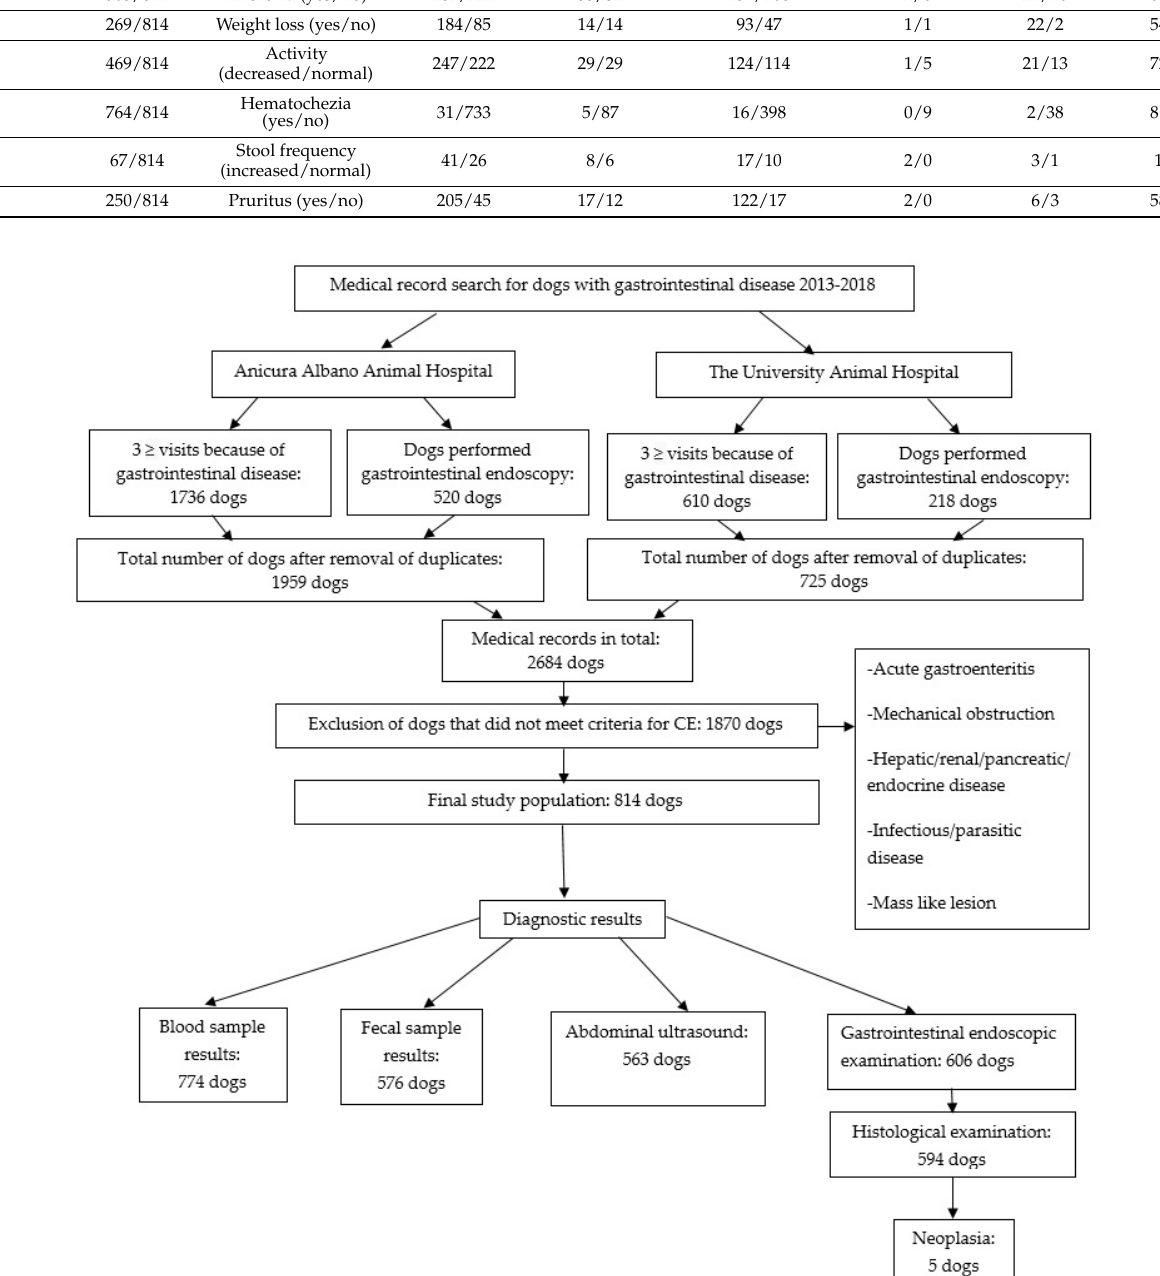
Figure 1. Flowchart describing the establishment of the final study population of 814 dogs and number of individual dogs that had undergone specific tests in this group. Table 1. Summary of signalment variables, presenting signs, and follow up information by treatment outcome group.